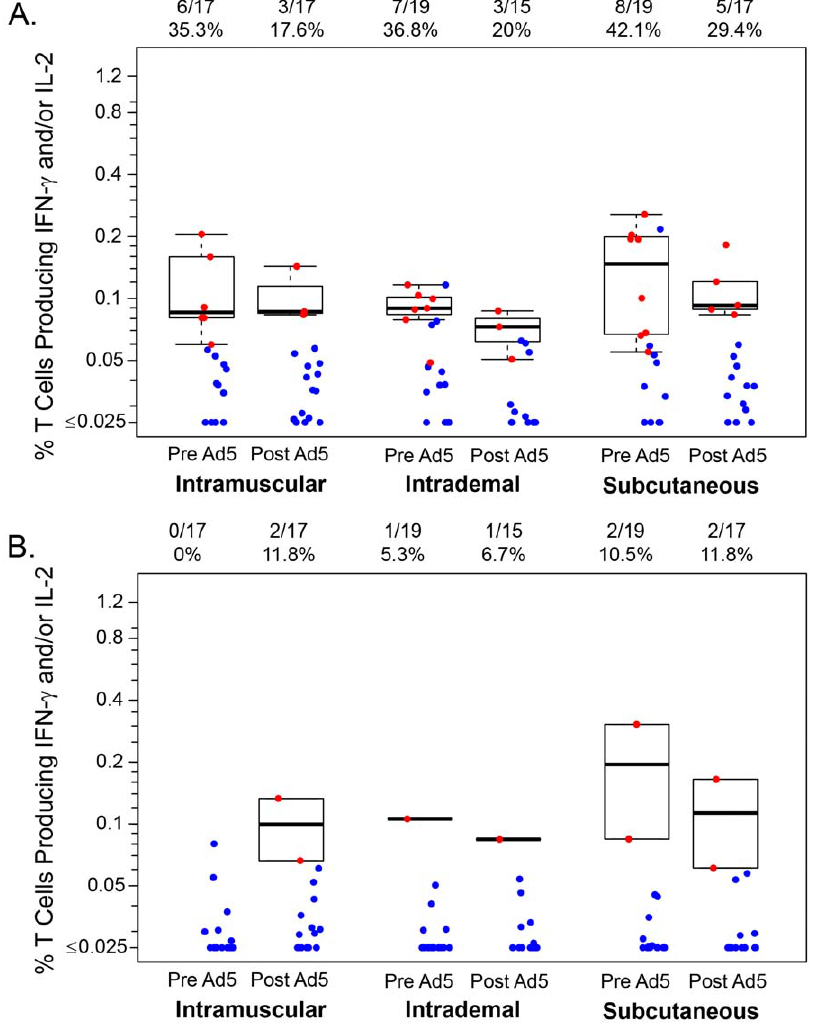
Figure 4. Percentage of CD4 + T cells producing interferon c and/or Interleukine 2 by administration route. (A) in response to any Env peptides (B) in response to any Gag peptides before (2 weeks post last DNA prime) and after the Ad5 boost (4 weeks post Ad5